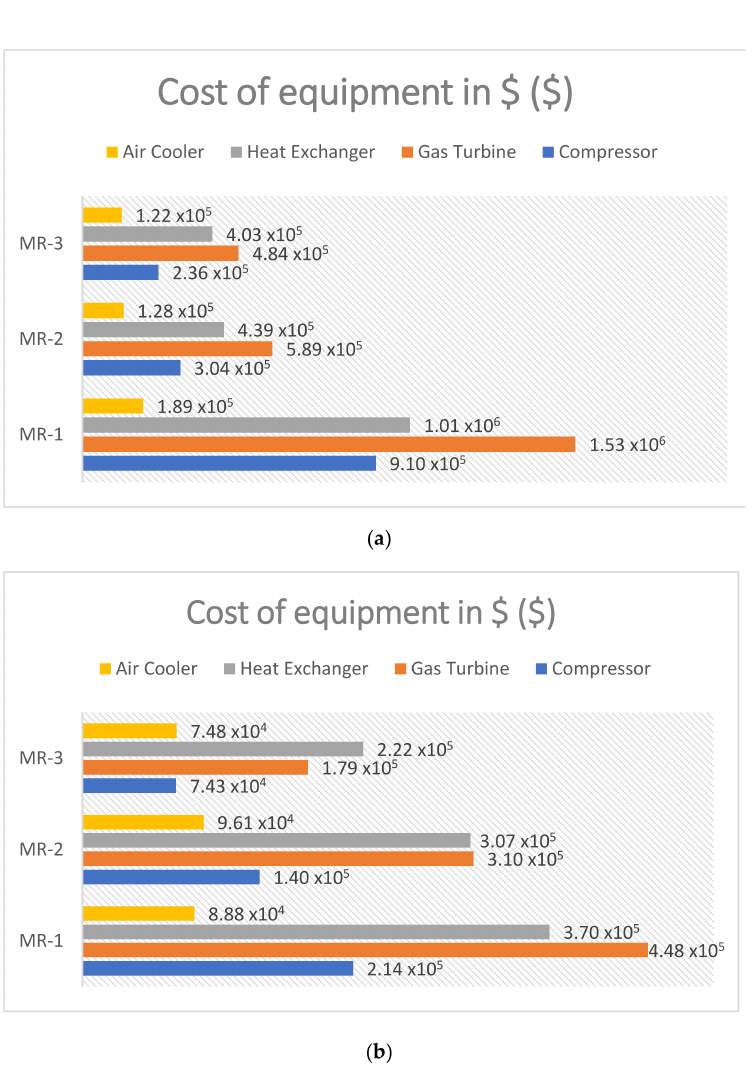
Figure 7. Capital cost of major equipment of natural gas pre-cooling cycle for one train. ( a ) MR-1, MR-2 and MR-3 base case with 20% ammonia; ( b ) MR-1, MR-2 and MR-3 with 30% ammonia.